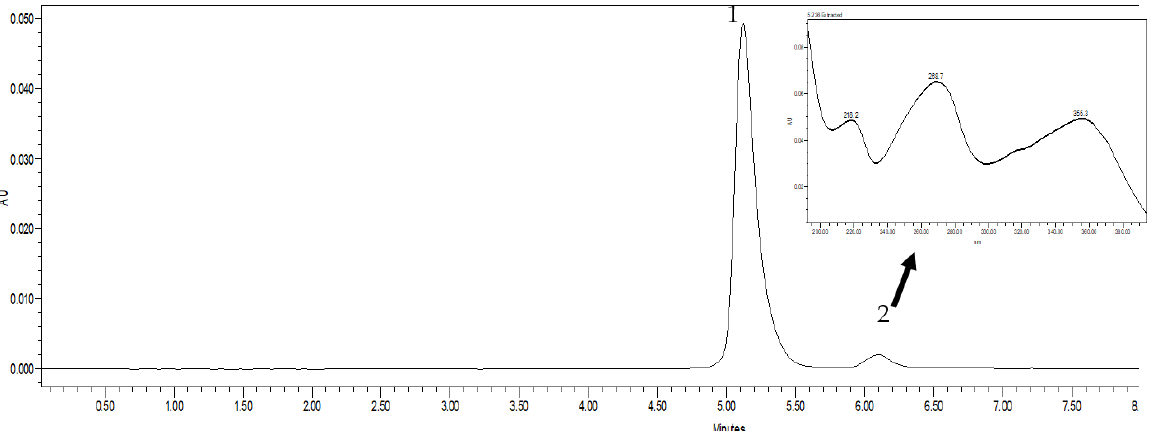
Figure 6. Chromatogram of oxytetracycline in the polyphosphate ester-type P6 transporter. Along with the main peak of oxytetracycline, there are three peaks with reduced mobility in the chromatograms. Under these conditions, an antibiotic base and accompanying unidentified components are detected. The proportion of unidentified components ranges from 1.4 to 4.7%. Oxytetracycline content was 11.9 mg/mL in the oxytetracycline + P4 complex and 12.2 mg/mL in the oxytetracycline + P6 complex. The results show that the efficiency of complex formation between polyphosphate ester -type transporters (P4 and P6) and oxytetracycline is similar for the two studied polymers. 3.3. Antibacterial Activity Oxytetracycline, when complexed with polyphosphate ester transporters, increased the susceptibility of S. aureus to oxytetracycline. Inhibition of S. aureus growth is most pronounced at the minimum dose (2.3 µg/disk) of oxytetracycline + P4 ( Figure 7, Table 1). The growth inhibition is higher by 37.5% ( p < 0.01) compared to the actions of oxytetracycline hydrochloride and oxytetracycline + P6. The growth inhibition of the microorganism was observed using higher doses of oxytetracycline + P4. The inhibition of growth was also greater compared to controls ( p < 0.01).